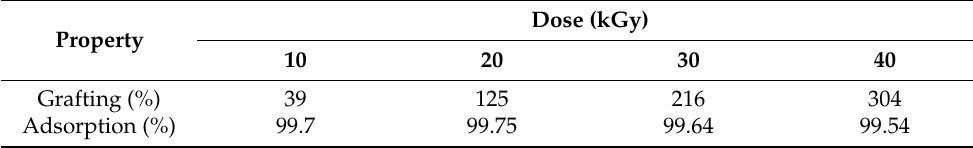
Table 4. Co(II) uptake by radiation processed (PP-g-(AN-co)AAc-H 2 PO 3 ) [114].